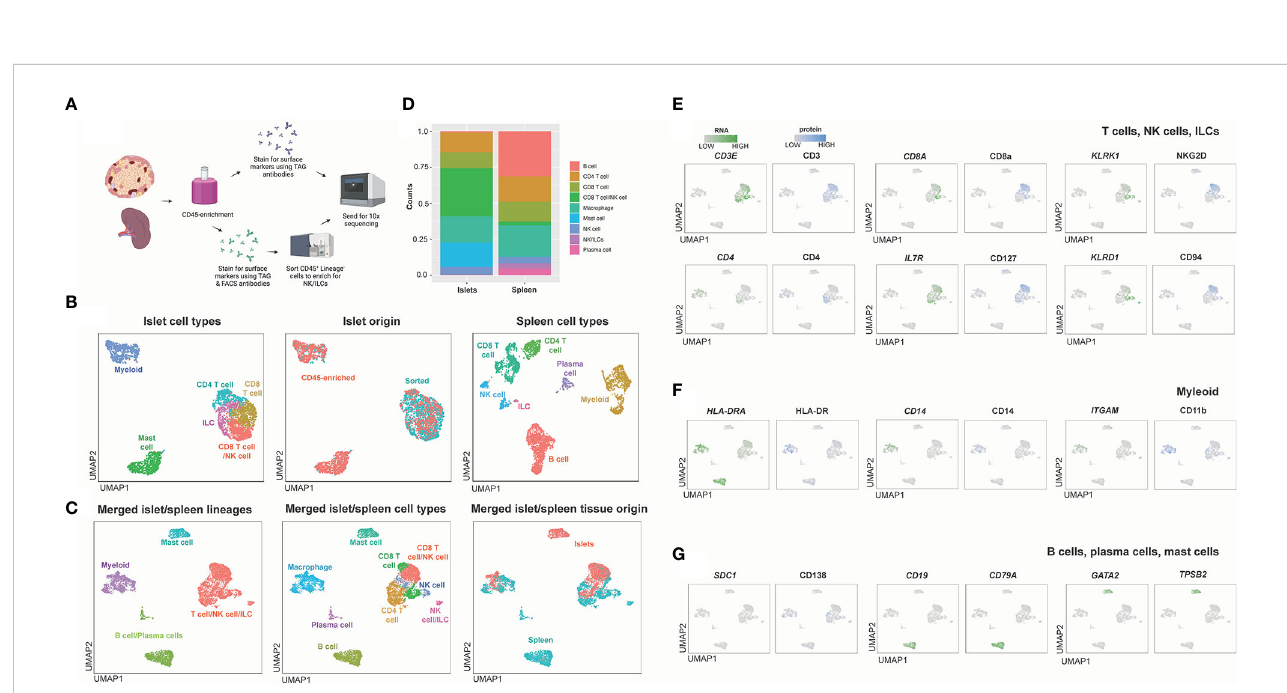
FIGURE 6 Work fl ow and combined islet and spleen lineage maps. (A) Example work fl ow of CITE-seq. Spleen and islet samples were enriched for CD45 + immune cells. Immune cells from spleen were stained with oligo-antibody conjugated TotalSeqC antibodies and sent for 10x sequencing. Islet immune cells were either were stained with oligo-antibody conjugated TotalSeqC antibodies or stained for both oligo-antibody conjugated TotalSeqC and fl ow cytometry antibodies at the same time and FACS sorted to enrich for NK cells and ILCs and then sent for 10x sequencing. (B) UMAPs of islet cell types, islet cell origin (FACS sorted or CD45-enriched), and spleen cell types. (C) Merged islet and spleen lineage, cell types and tissue of origin UMAPs. (D) Composition of cell types from each organ. (E) T, NK and ILC lineage markers. (F) Myeloid lineage markers. (G) B cell, plasma cell and mast cell lineage